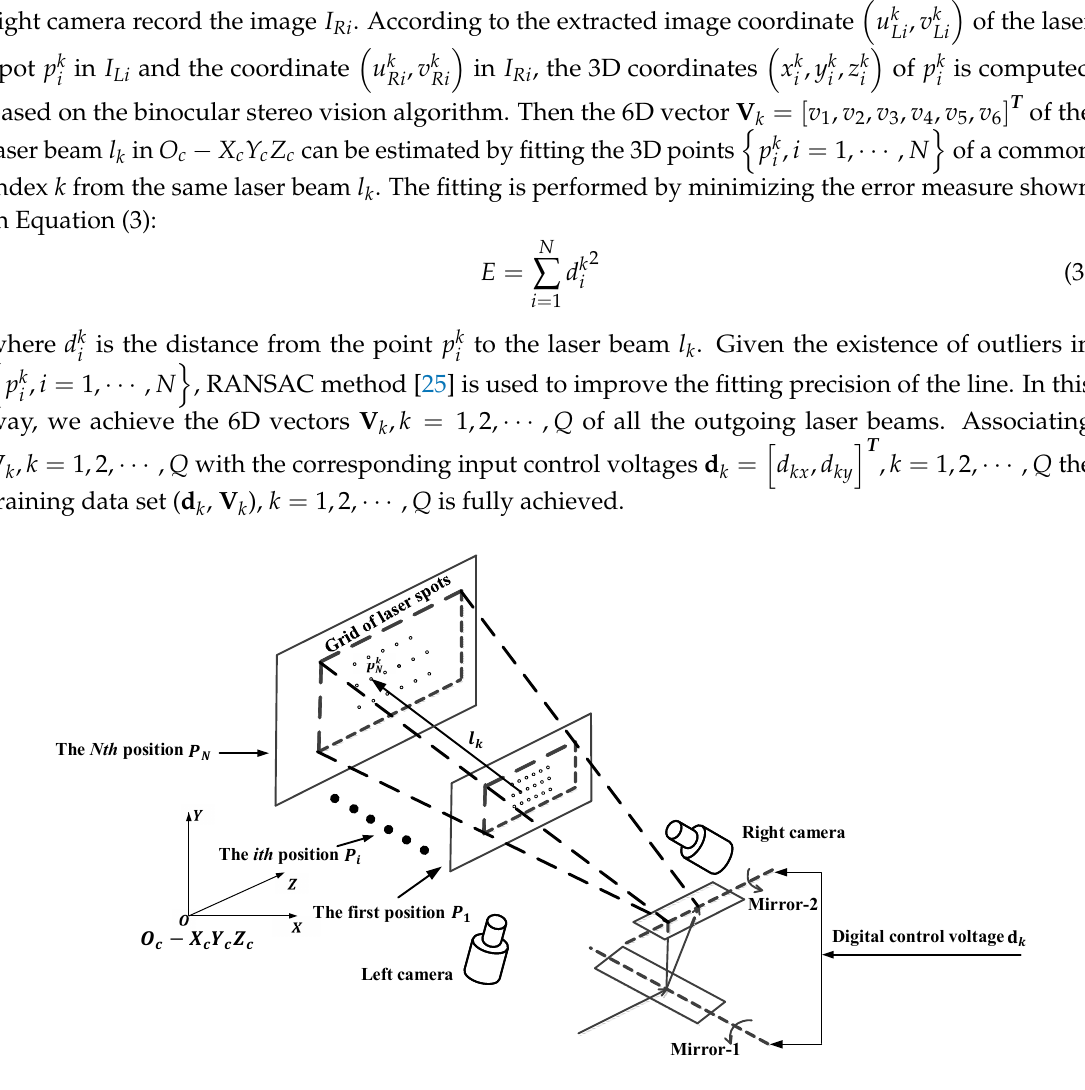
Figure 4. Generating the calibration data.